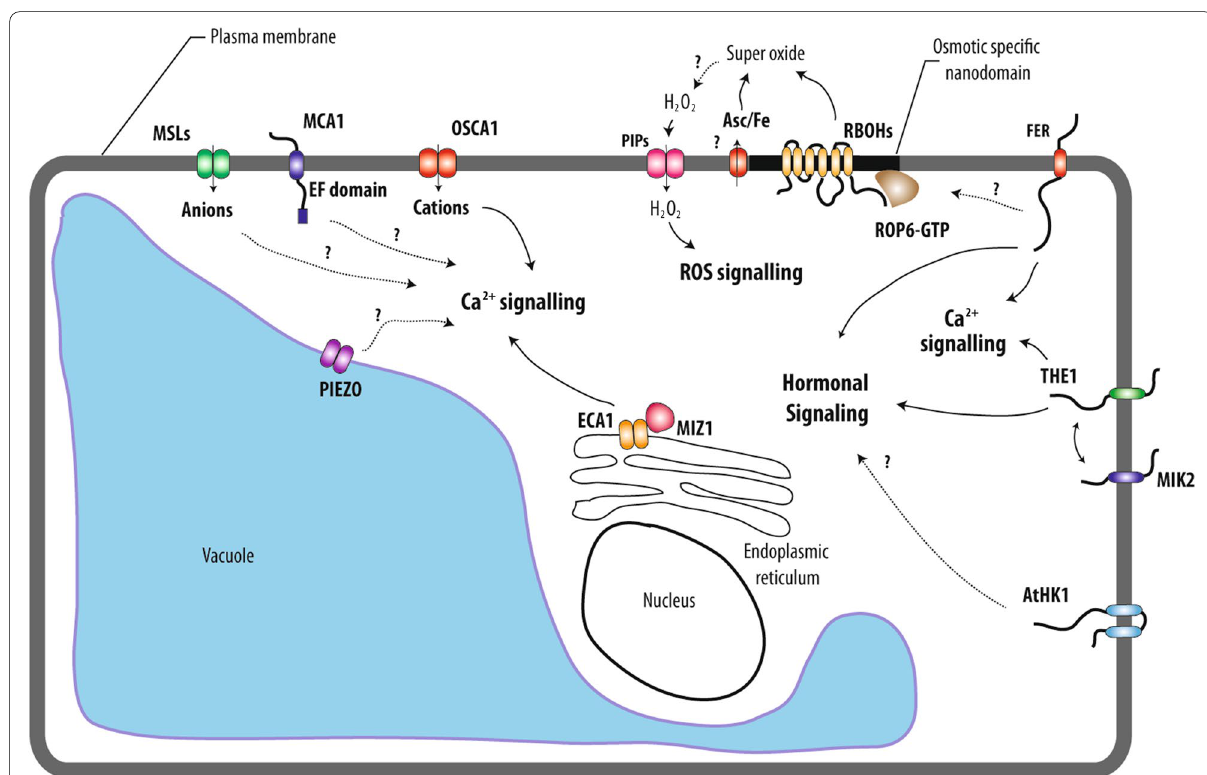
Fig. 2 Summary of currently known osmotic perception mechanisms in plants. Changes in membrane tension induced by osmolarity imbalance can be perceived by membrane mechanosensors such as OSCA1, MSLs, MCA1, PIEZO, ECA1/MIZ1. By transporting cations or anions, these sensors initiate cell calcium signaling by as yet unknown mechanisms. Receptor-like kinases belonging to the CrRLK family (e.g. FER, THE) perceive the cell wall status and their activation eventually leads to cell wall reinforcement. Whereas their exact role as osmotic sensors has yet to be established, these receptors definitely fine tune signaling of hormones such as ABA, auxin and jasmonate that are known to regulate plant development and physiological acclimation to osmotic stress. At the cell membrane, a partial integration of signals can be observed. For instance, LRR kinase MIK2, a receptor for phytocytokines that controls plant immunity, genetically interacts with THE, pointing to a link between osmotic and pathogen signaling. By similarity to the yeast system, the AtHK1 two component histidine kinase may also participate in osmotic signaling by modulating ABA signaling. In addition to hormones and calcium signaling, Reactive Oxygen Species (ROS) are also participating in early cell responses to osmotic stimuli. Cellular accumulation of ROS is dependent on NADPH oxidases (RBOHD and F) and iron reduction processes. Upon cell stimulation, ROP6 forms nanodomains together with the superoxide producing enzyme RBOHD/F. As a consequence, superoxide can be dismutated to hydrogen peroxide